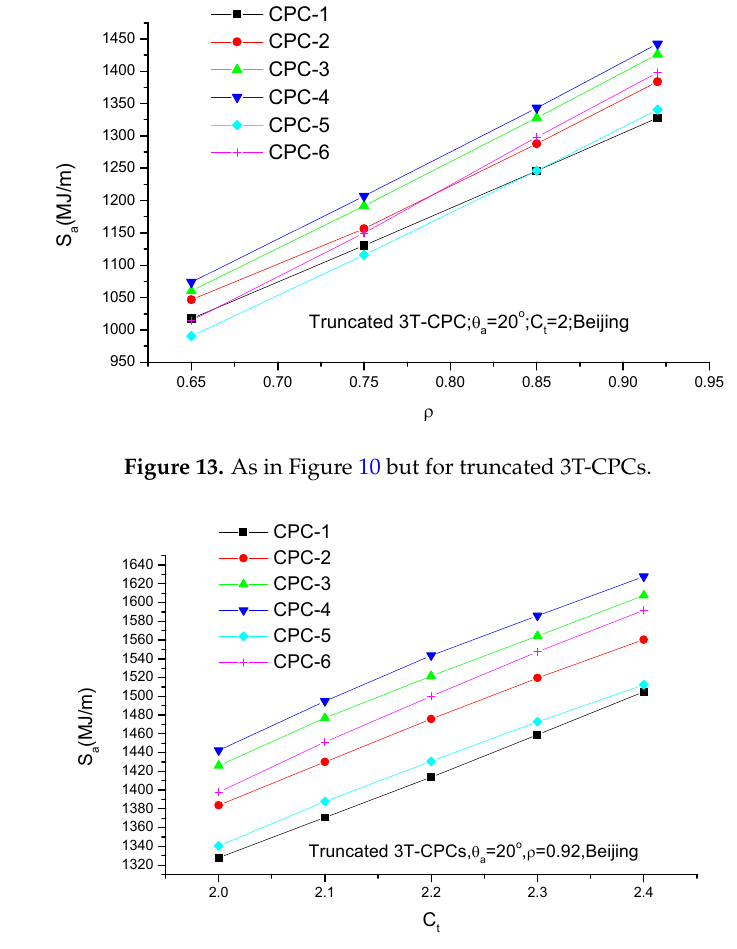
Figure 12. As in Figure 10 but for full 3T ‐ CPCs.